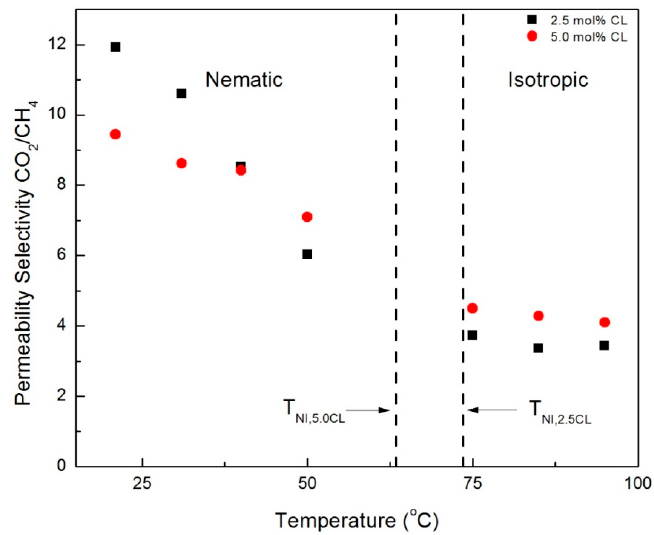
Figure 9. Propylene/propane permeability selectivities in the nematic and isotropic phases for membranes prepared with 2.5% and 5.0% crosslinker (CNBPh75_2.5 and CNBPh75_5.0).